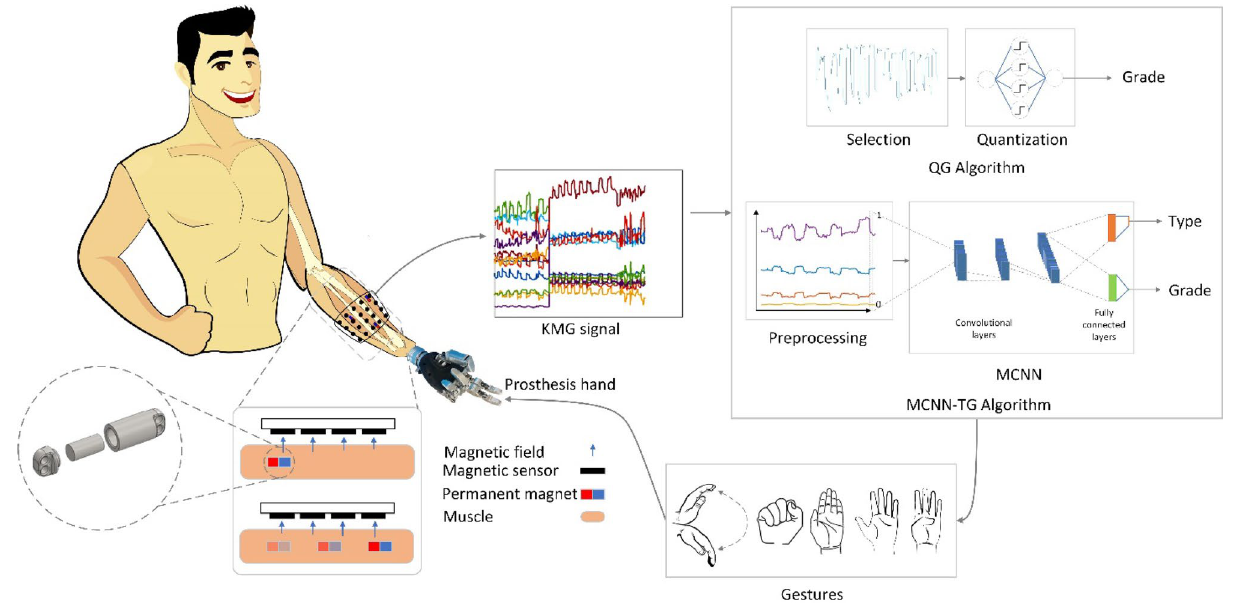
Figure 1. The general structure of the prosthesis hand controlled by the KMG signals. The number of KMG signal channels generated from the implanted magnets is proportional (one channel for each Cartesian coordinate) to the number of sensors. This signal is used to directly drive the